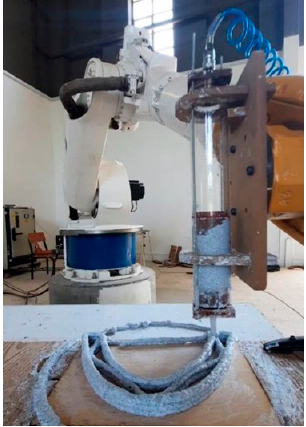
Figure 12. The printing session of one of the arches (Image credit: Authors).